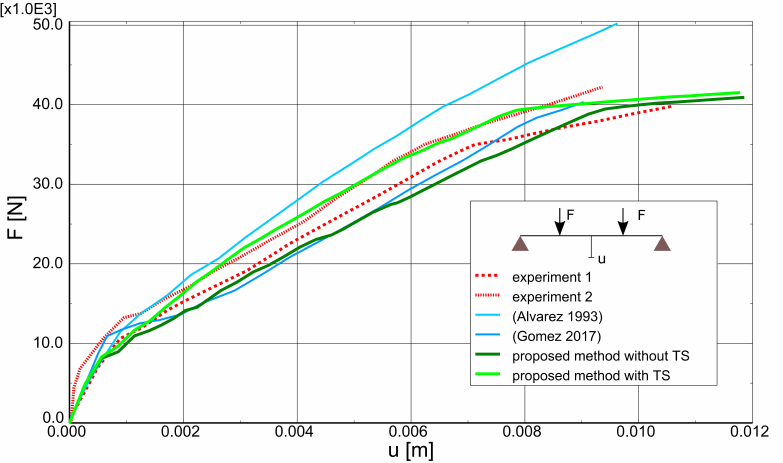
Figure 17. Beam failure in bending—influence of tension stiffening